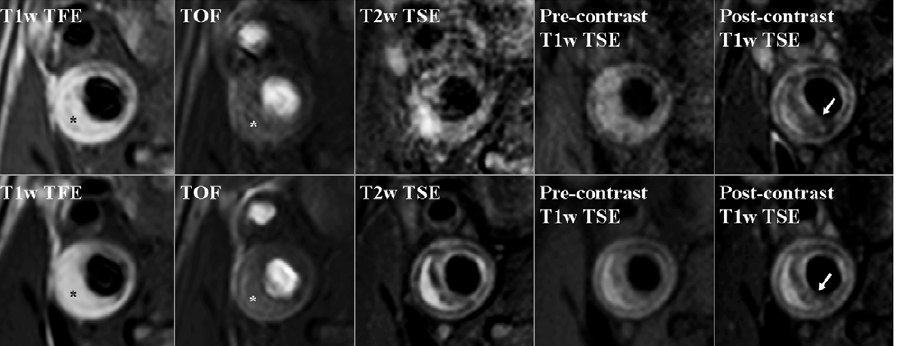
Figure 1. Multisequence MR images of a plaque in the internal carotid artery obtained at baseline (upper row) and after one year (bottom row). The TOF and T2w TSE images at baseline are slightly blurred due to patient motion. There is no obvious change of plaque morphology. There is a plaque with a LRNC and IPH (asterisks) at baseline and at 1-year follow-up. There is a disruption of the FC at both time points